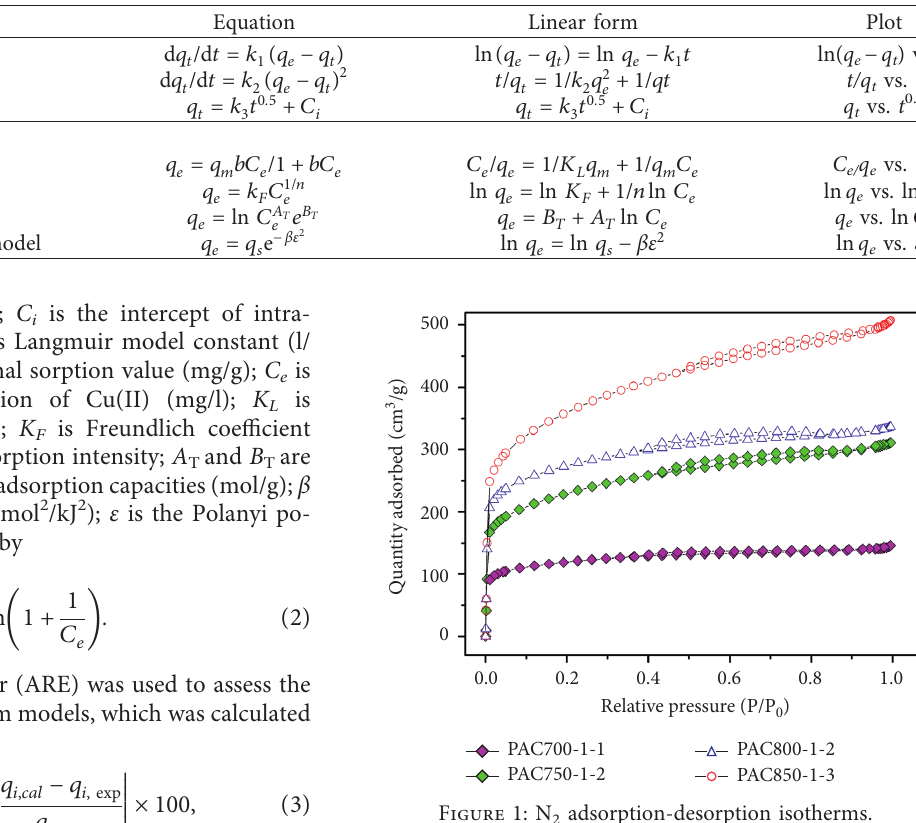
Table 1: Kinetic and isothermal models used in this study.